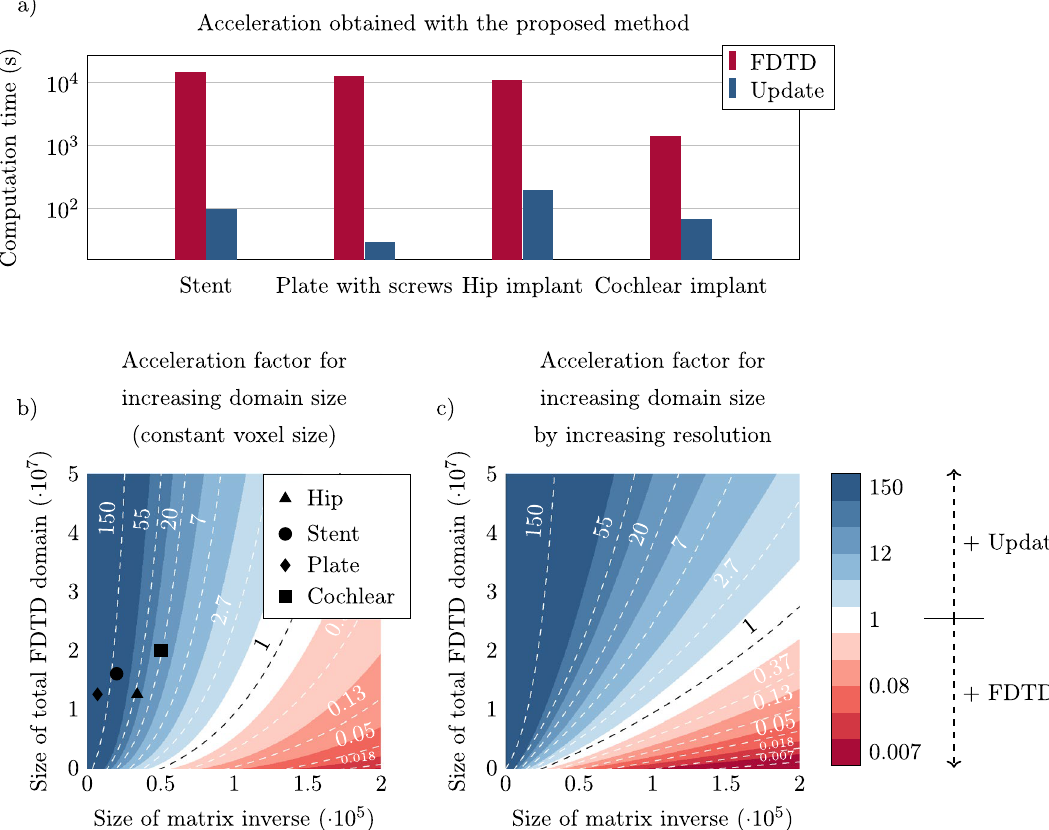
Figure 8. ( a ) Acceleration obtained with the proposed method over the standard FDTD method for the four implants that have been tested. ( b ) Acceleration of the proposed method in comparison to traditional FDTD simulation as a function of the domain size when the voxel size in the FDTD simulation is kept constant. The x-axis of the plot shows the size of the matrix to be inverted (small domain). The y-axis displays the size of the total FDTD simulation domain. To offer perspective on realistic problem sizes, the domain sizes of four implants that are investigated in this work are indicated by markers. ( c ) Acceleration gained with the proposed method as a function of the domain size, however, now the size of the FDTD domain is increased by increasing the resolution. A blue color indicates the proposed method is faster while a red color indicates the FDTD method is